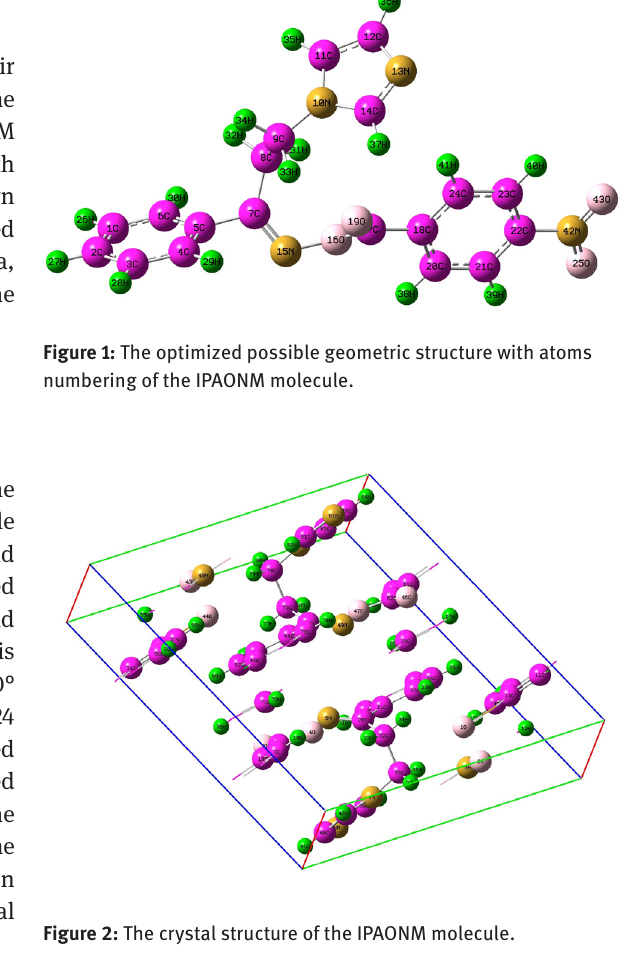
Figure 2: The crystal structure of the IPAONM molecule.